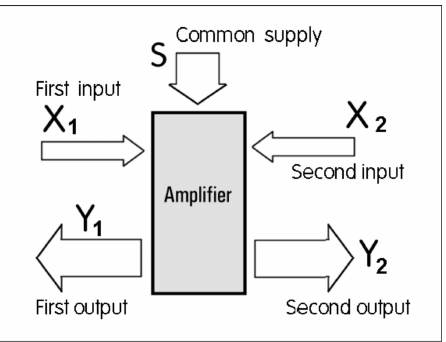
Figure 7. Schematic presentation—in a manner similar to the simple single-channel amplifier in Figure 3—of the typical amplifier shown in Figure